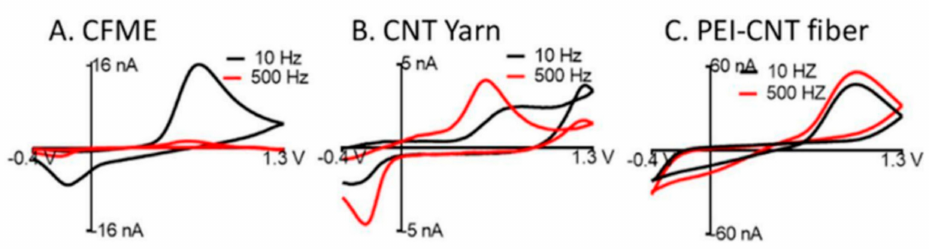
Figure 7. CV of 1 µ M dopamine at 2000 V / s for ( A ) carbon fiber microelectrode (CFME) ( B ) CNT yarn, and ( C ) PEI-CNT fiber electrodes, demonstrating a consistent signal even at a high temporal resolution of PEI-CNT fibers. Reprinted with permission